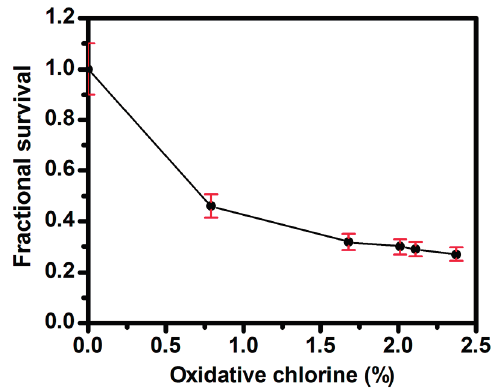
Figure 5. Effect of oxidative chlorine content of SiO 2 @PS/ N -halamine NPs on the antibacterial